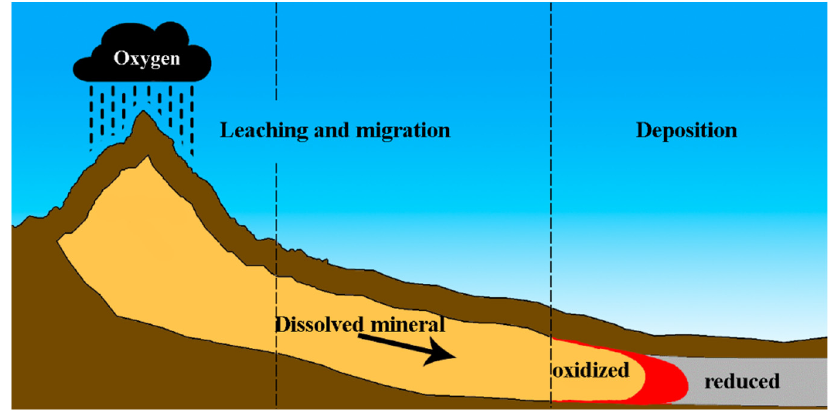
Figure 1. Phases of uranium deposit genesis: migration and deposition.